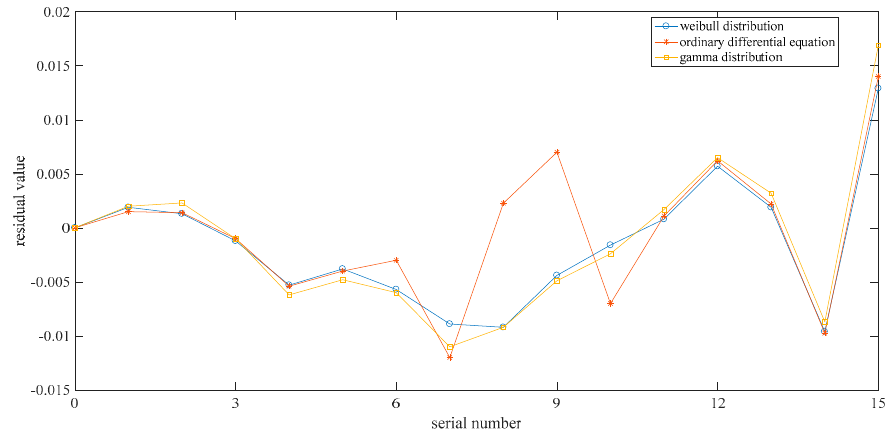
Figure 3. Residual value between the actual state and the expected state of the gearbox.